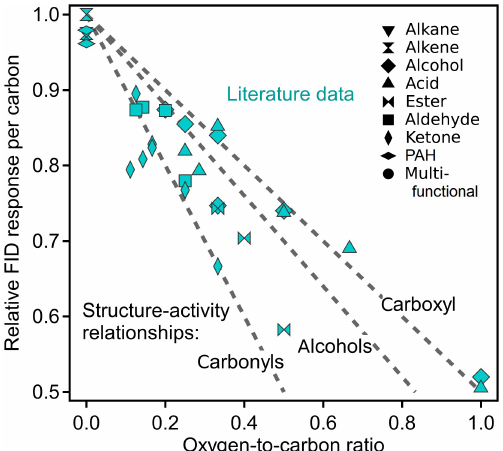
Figure 1. Plot of relative ECN versus O / C ratios based on literature values. Literature data are from Scanlon and Willis (1985), repre- senting a variety of functional groups shown as different shapes. Dashed lines are the theoretical slopes of compounds comprised completely of labeled functional groups, based on the structure– activity relationship provided by Scanlon and Willis (1985). In con- trast to that of the carbonyls and carboxyls, the theoretical slope of alcohols is not structure independent and is based on a chosen sub- set of alcohols. Compounds used to develop the alcohol slope are provided in Table